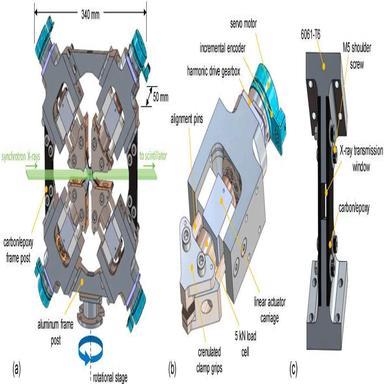
Detailed view of (a) in-situ biaxial load frame, (b) loading stage, and (c) vertical carbon/epoxy frame post.